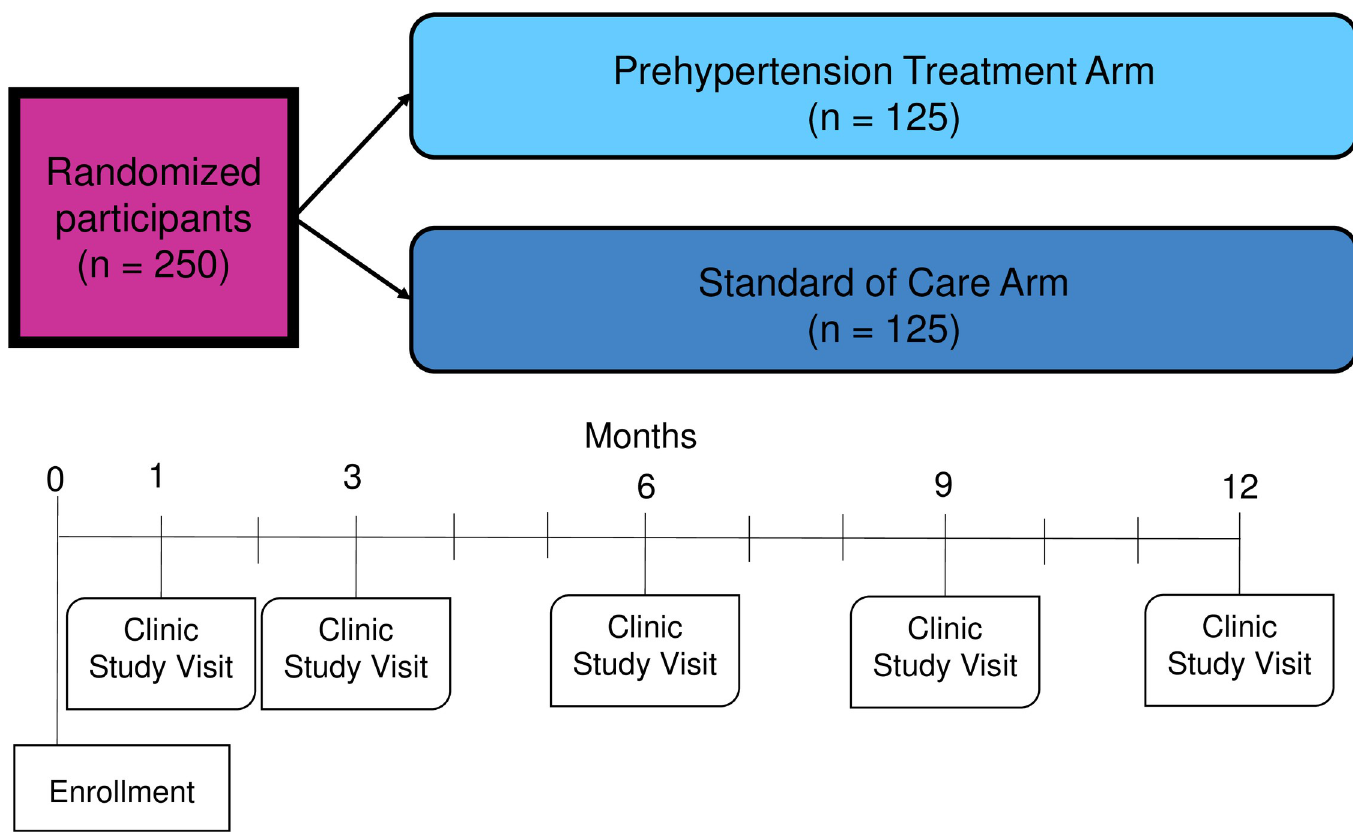
Fig 2. Study overview. Study follow-up visits will occur in the GHESKIO Clinic, with community visits to measure BP offered in months 2, 5, and 8.